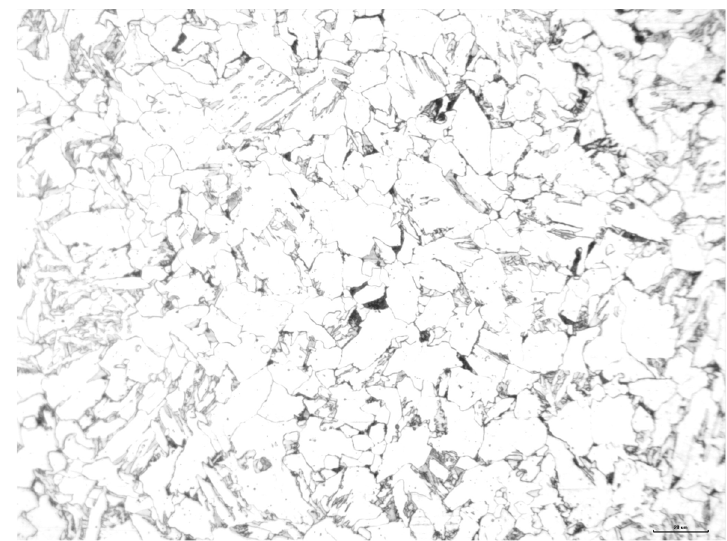
Fig. 4 Structure of filling layer of girth